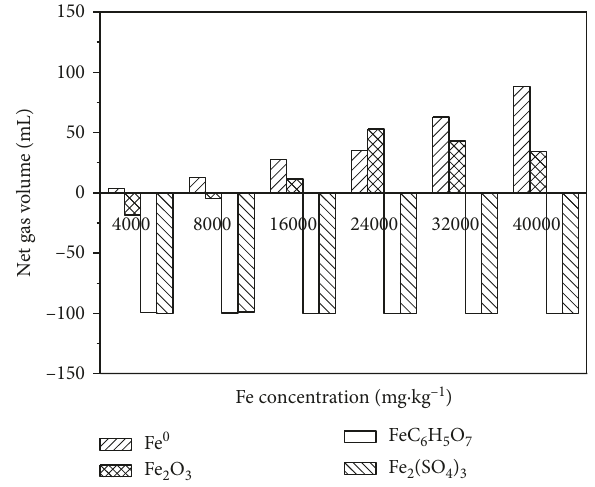
Figure 4: Effect of different iron sources on net CH